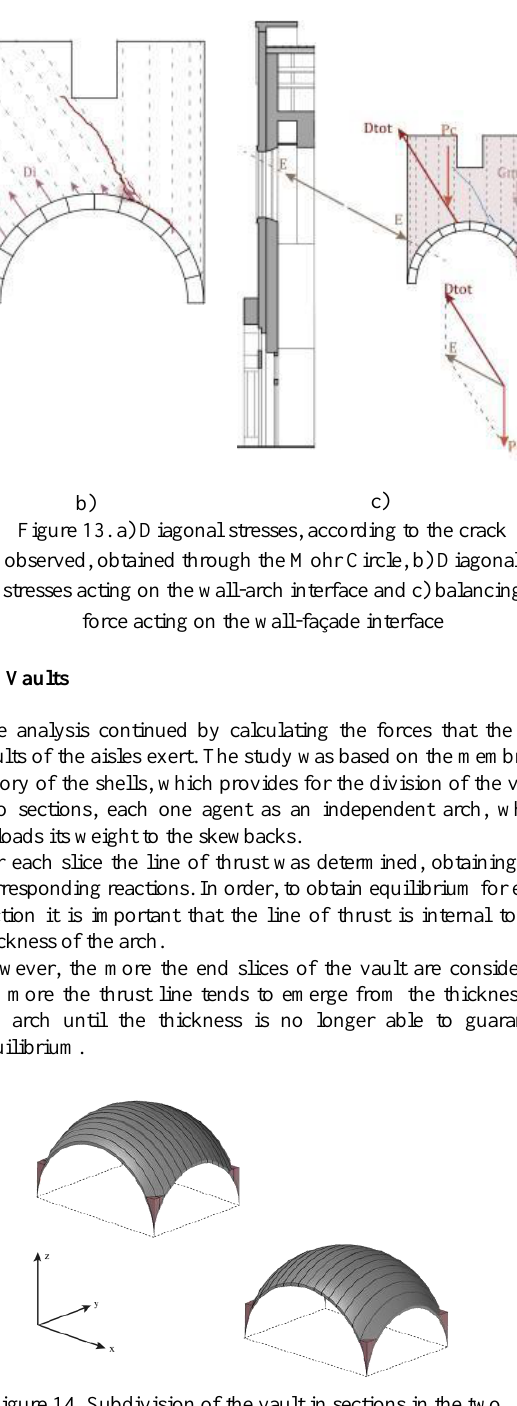
Figure 14. Subdivision of the vault in sections in the two directions X,